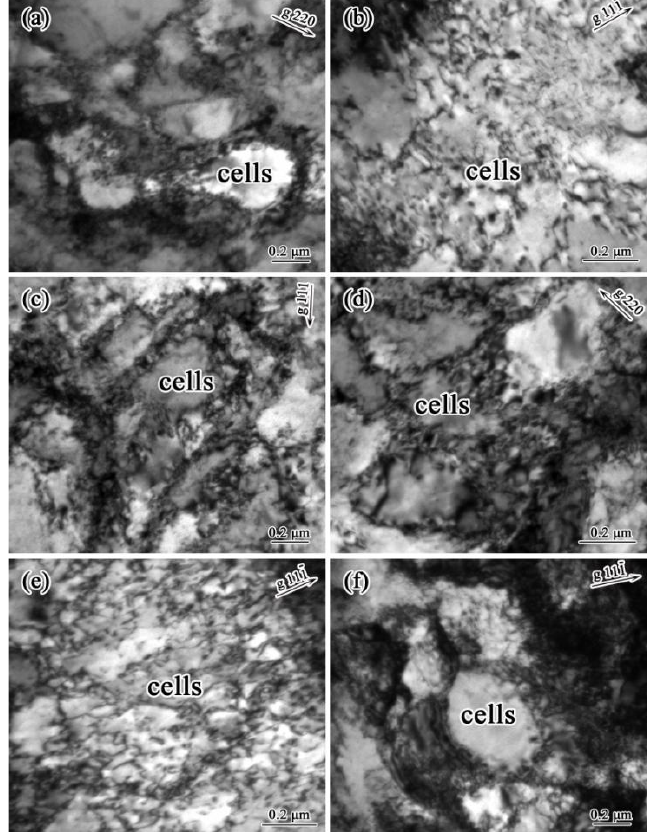
Figure 5. TEM images of dislocation configurations of unfatigued or pre-fatigued [ 233 ] Cu single crystals under uniaxial compression: ( a ) unfatigued, B = 111; pre-fatigued at ( b ) γ pl = 1.3 × 10 − 4 , B = 011; ( c ) γ pl = 3.4 × 10 − 4 , B = 101; ( d ) γ pl = 9.2 × 10 − 4 , B = 111; ( e ) γ pl = 3.5 × 10 − 3 , B = 011; and ( f ) γ pl = 5.3 × 10 − 3 , B = 011.